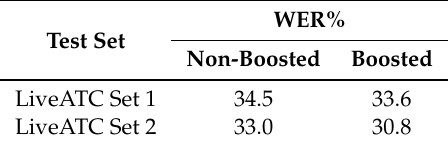
Table 3. Boosting of call sign lists from surveillance